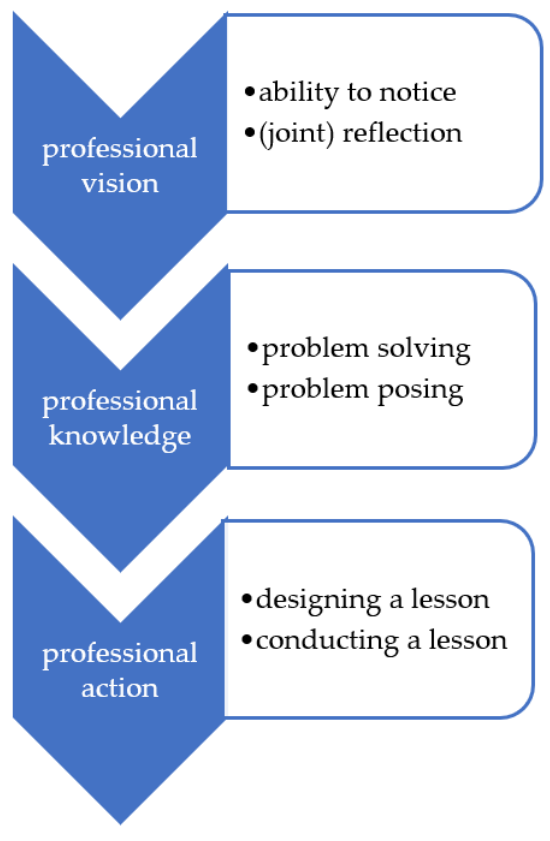
Figure 2. Three dimensions of a teacher’s professionalism [72] and its projection in the analyzed studies (schematized by the authors of this article). studies (schematized by the authors of this